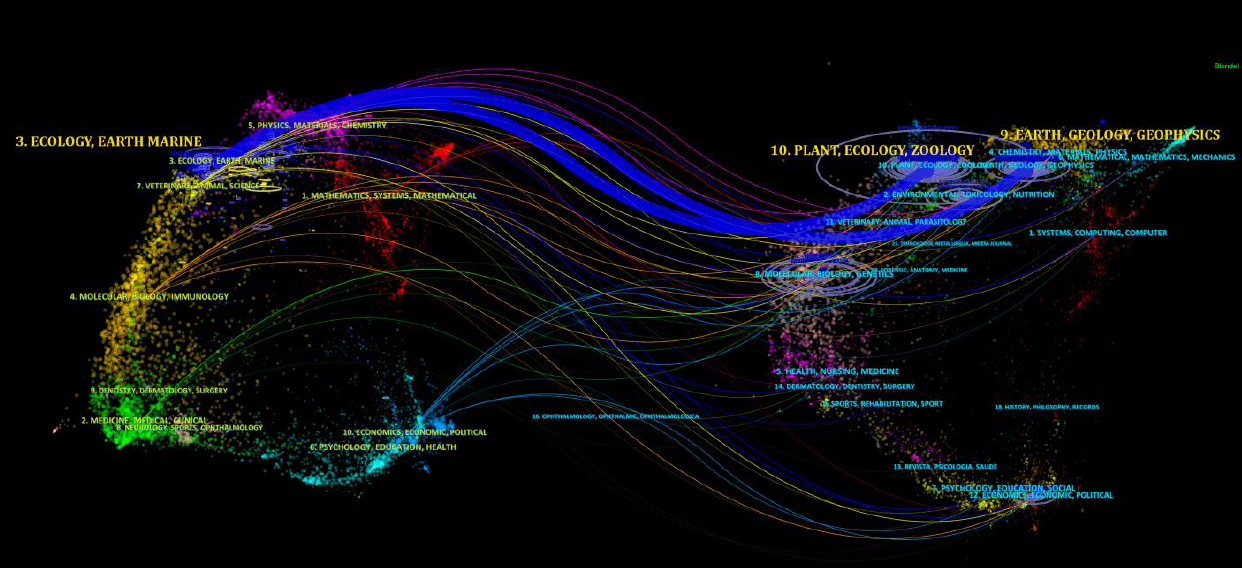
Figure 14. Domain-level citation patterns in mangrove and climate change-related research from 1977 to